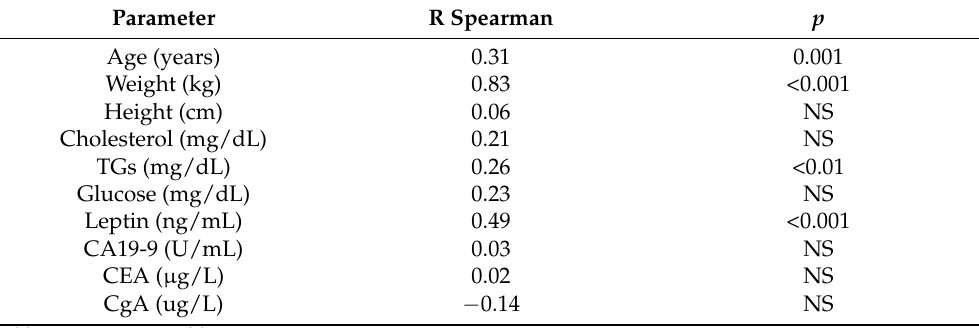
Table 3. Spearman’s correlations between BMI and clinical and biochemical characteristics in